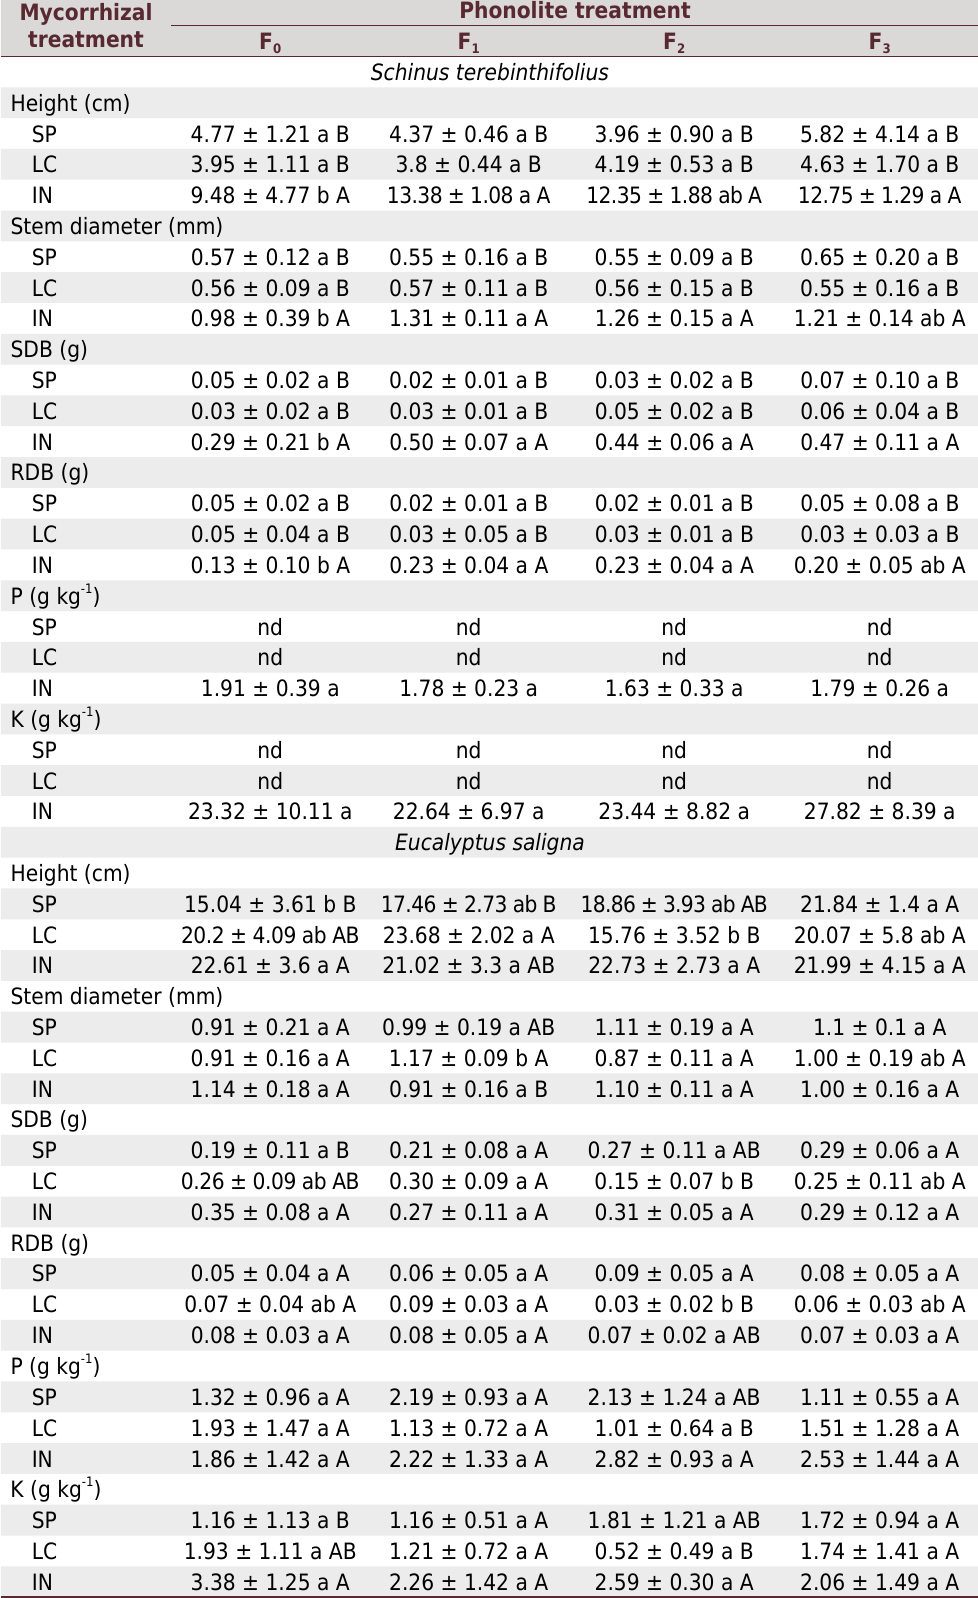
Table 2. Height, stem diameter, shoot (SDB) and root (RDB) dry biomass, shoot phosphorus (P), and shoot potassium (K) of Schinus terebinthifolius and Eucalyptus saligna at different particle sizes of phonolite [no phonolite (F 0 ) and addition of phonolite in particle sizes of 0.037 mm (F 1 ), 0.074 mm (F 2 ), and 0.149 mm (F 3 )] and mycorrhizal inoculation